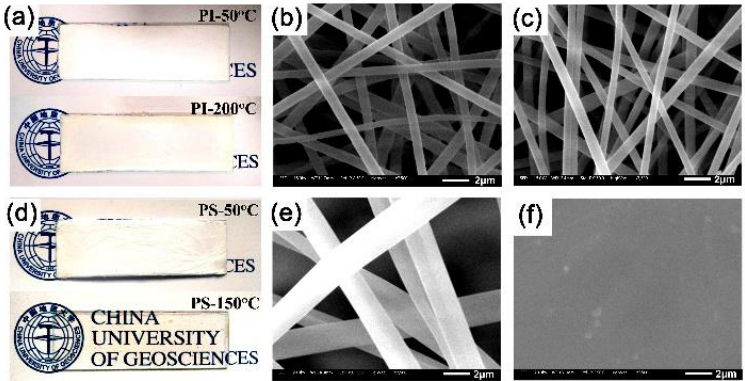
Figure 10. Thermal stability of the high-whiteness membranes. ( a ) Appearance of PI-3 membrane after heat treatment (upper: PI-50 ◦ C; lower: PI-200 ◦ C); ( b ) SEM image of PI-3 membrane after thermal treatment at 50 ◦ C for 1 h; ( c ) SEM image of PI-3 membrane after thermal treatment at 200 ◦ C for 1 h; ( d ) Appearance of PS membranes after heat treatment (upper: PS-50 ◦ C; lower: PS-150 ◦ C); ( e ) SEM image of PS membrane after thermal treatment at 50 ◦ C for 1 h; ( f ) SEM image of PS membrane after thermal treatment at 150 ◦ C for 1 h.